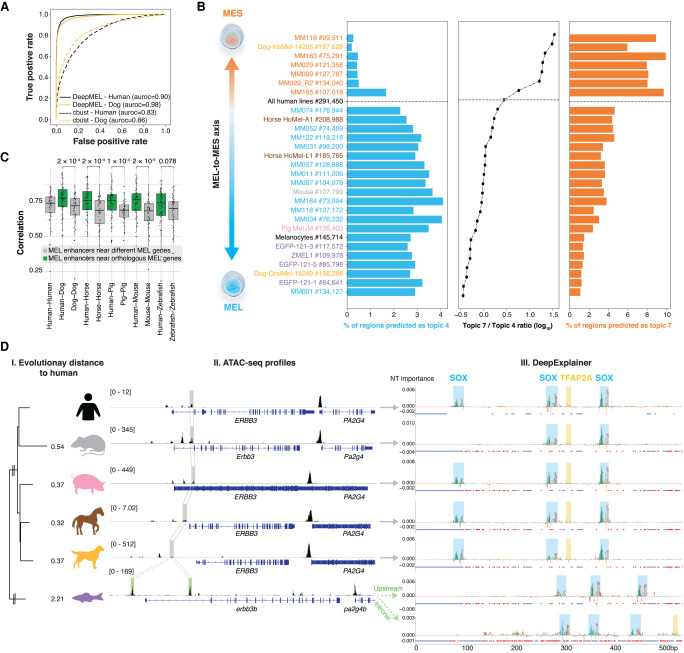
Human-trained deep learning model applied to cross-species ATAC-seq data. (A) Performance of DeepMEL and Cluster-Buster (cbust) in classifying MEL and MES differential peaks in human and dog. (B) Percentage of MEL- and MES-predicted ATAC-seq regions across all samples in our cohort and in human melanocytes. Samples are ordered according to the ratio of the number of MES/MEL-predicted regions. (C) Pearson's correlation of deep layer scores between MEL-predicted regions near orthologous MEL genes between human and another species (Human-Species) or between MEL-predicted regions near different MEL genes within one species (Species-Species). P-values of unpaired two-sample Wilcoxon tests are reported. (D) (I) Evolutionary distance between human and other species in branch length units. (II) ATAC-seq profiles of the ERBB3 locus in the six species. MEL-specific enhancers that were predicted by DeepMEL and that were also found (gray) or not found (green) via liftOver of the human MEL enhancer are highlighted. (III) DeepExplainer plots for the multiple-aligned MEL-predicted ERBB3 enhancers. Red and blue dots represent point and indel mutations, respectively.